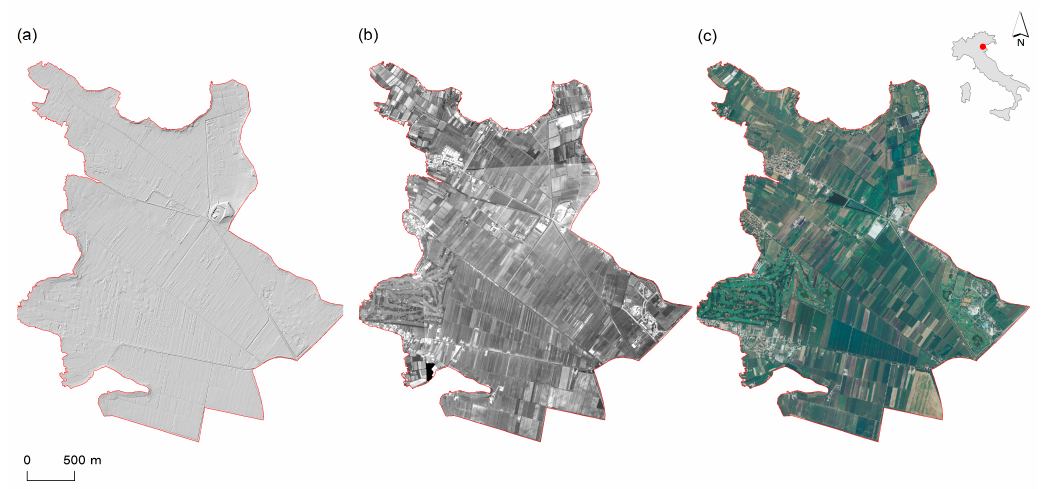
Figure 1. Available topographic data: ( a ) LiDAR DTM (Ministero dell’Ambiente e della Tutela del Territorio e del Mare-Geoportale Nazionale-REGOLAMENTO (UE) No. 1089/2010), ( b ) Aerial photograph of 1983 (Regione del Veneto-L.R. n. 28/76 Formazione della Carta Tecnica Regionale), and ( c ) Orthophoto of 2006 (Ministero dell'Ambiente e della Tutela del Territorio e del Mare-Geoportale Nazionale-REGOLAMENTO (UE) No. 1089/2010).